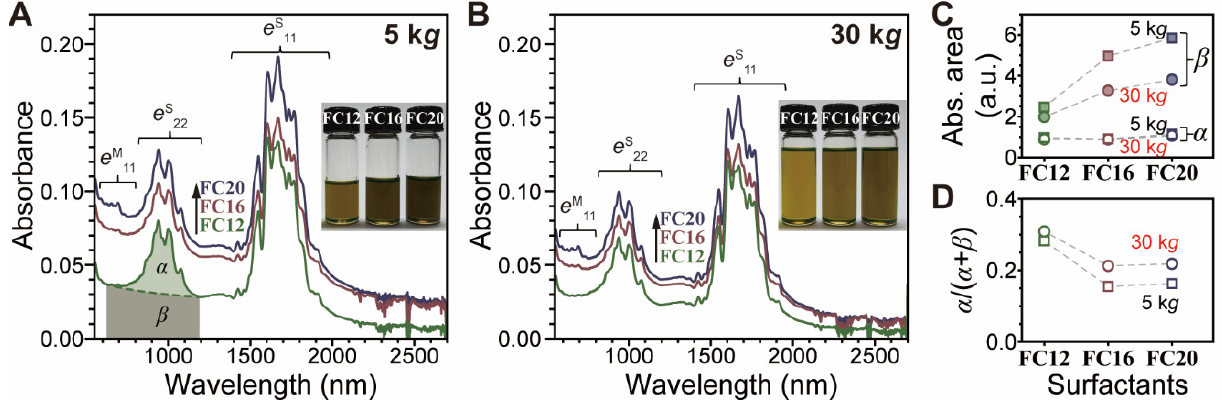
Figure 3. SWNT dispersibility of flavin derivatives as function of increasing l S and varying centrif- ugation force. UV-vis-SWIR absorption spectra of PSWNT dispersions by using FC12 (olive), FC16 (brown), FC20 (navy) and centrifugal forces of ( A ) 5 and ( B ) 30 k g . α and β denote SWNT contribution and background absorption, respectively. The noise signals in the region from 2500 to 2700 nm originates from infrared vibrations of residual water [48]. Insets display photographs of each set of the dispersions, showing tone-down of the dispersions with 30 k g . ( C ) α (empty), β (solid), and ( D ) α /( α + β ) contributions according to centrifugal forces (i.e., 5 k g (square) and 30 k g (circle)) and l S